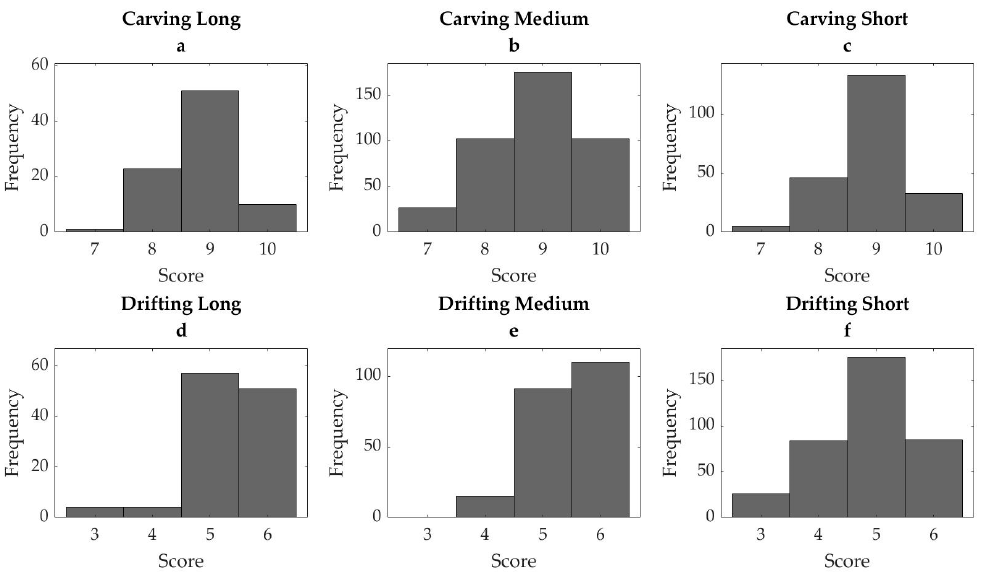
Figure 4. Distribution of algorithm-assigned scores from the test datasetfor the skiing styles carving and drifting in long ( a , d ), medium ( b , e ), and short ( c , f ) radius.